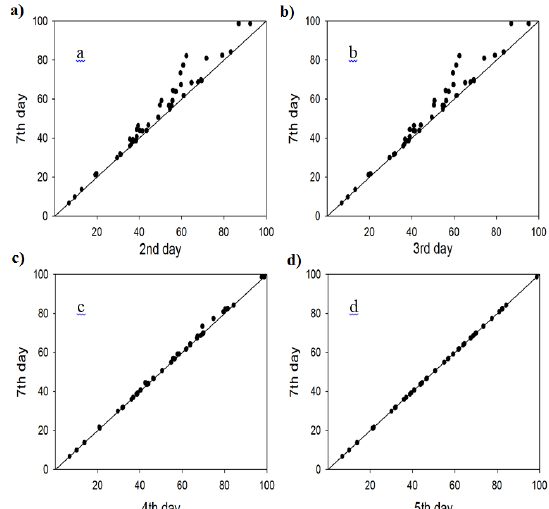
Fig. 4. Percent of seeds germinated in different days (2 nd (a), 3 rd (b), 4 th (c), and 5 th (d)) are shown after being placed in the condition of breaking secondary dormancy (alternative temperatures 3-30°C (light/darkness)) by line 1:1. The 7 th day was considered the last day according to the HSDT method.